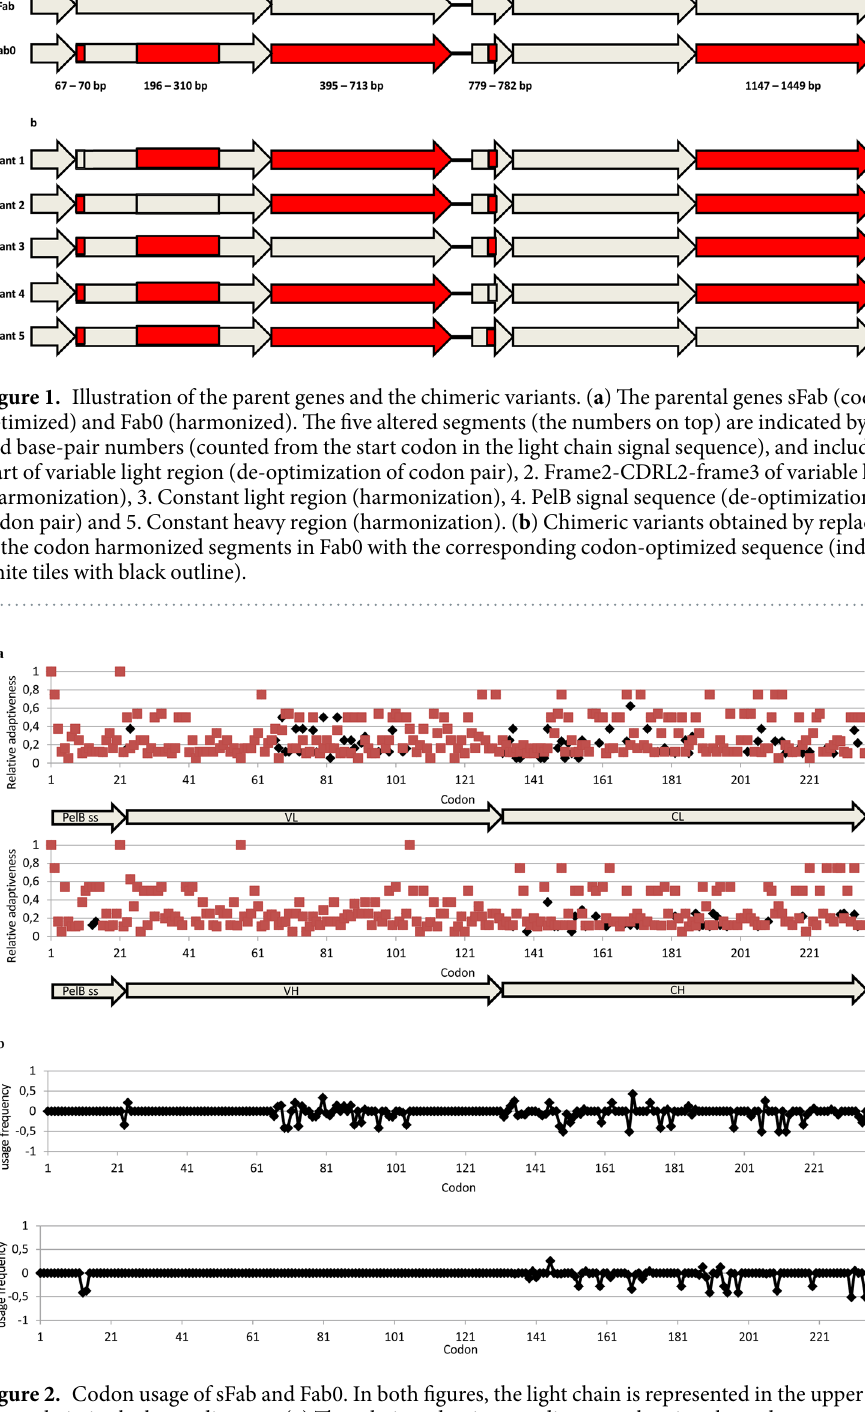
Fab0 codon usage frequency in Fig. 2b. The difference of codon usage frequency was calculated by subtracting the relative adaptiveness value of the codon in the sFab gene from the value of the corresponding codon in the Fab0 gene. The tAI-values for the parent genes Fab0 and sFab were 0.21 and 0.23 and for the variants 1, 2, 3, 4